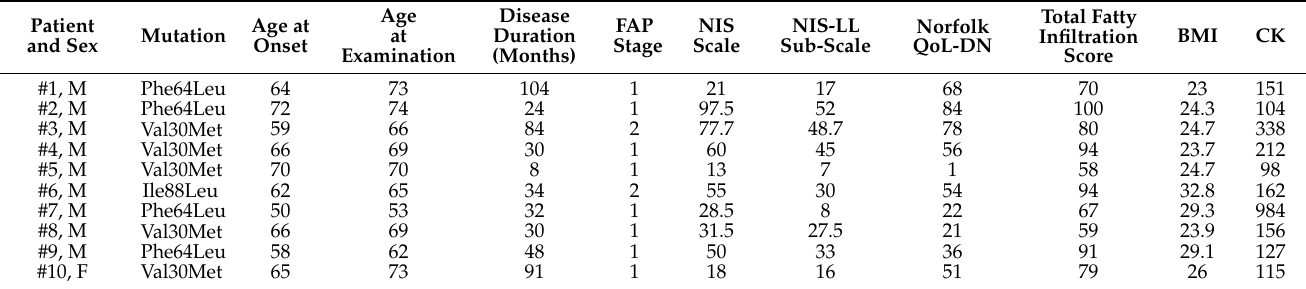
Table 1. Demographic and clinical findings of ATTRV patients.